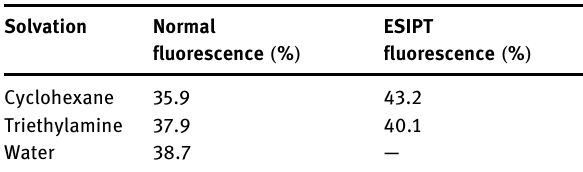
Table 4: The calculated quantum yields of normal fl uorescence and